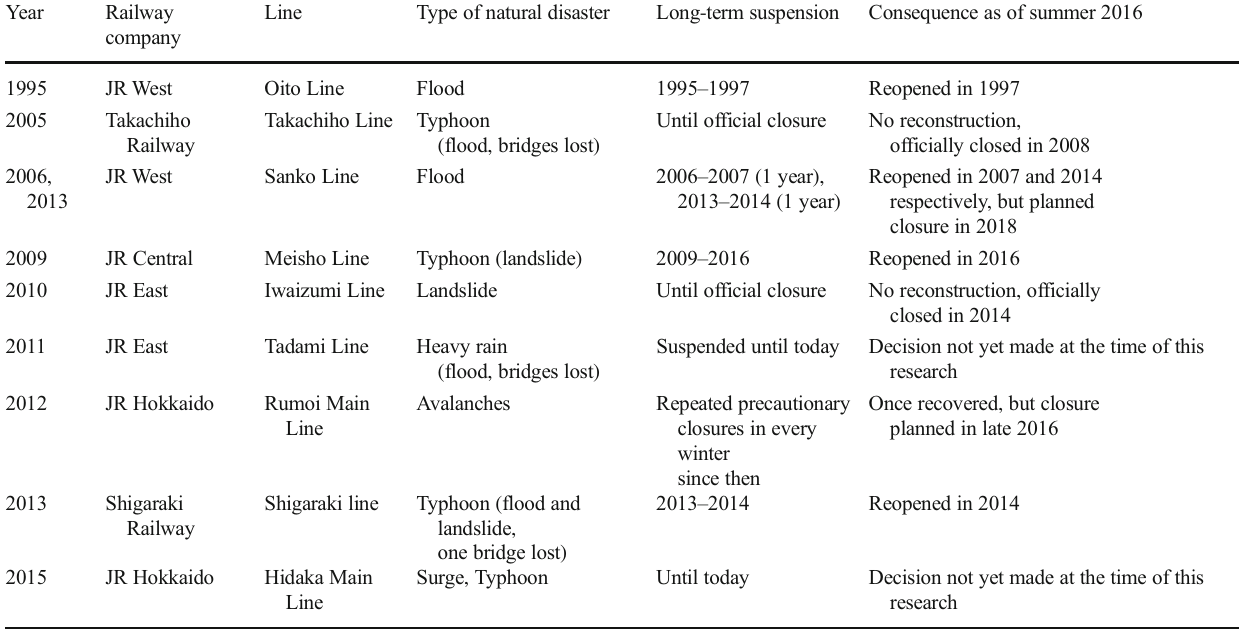
Natural disasters leading to severe damages to railways with B close-or-reconstruct ^ discussions since 1990s (as of Summer 2016) Year Railway